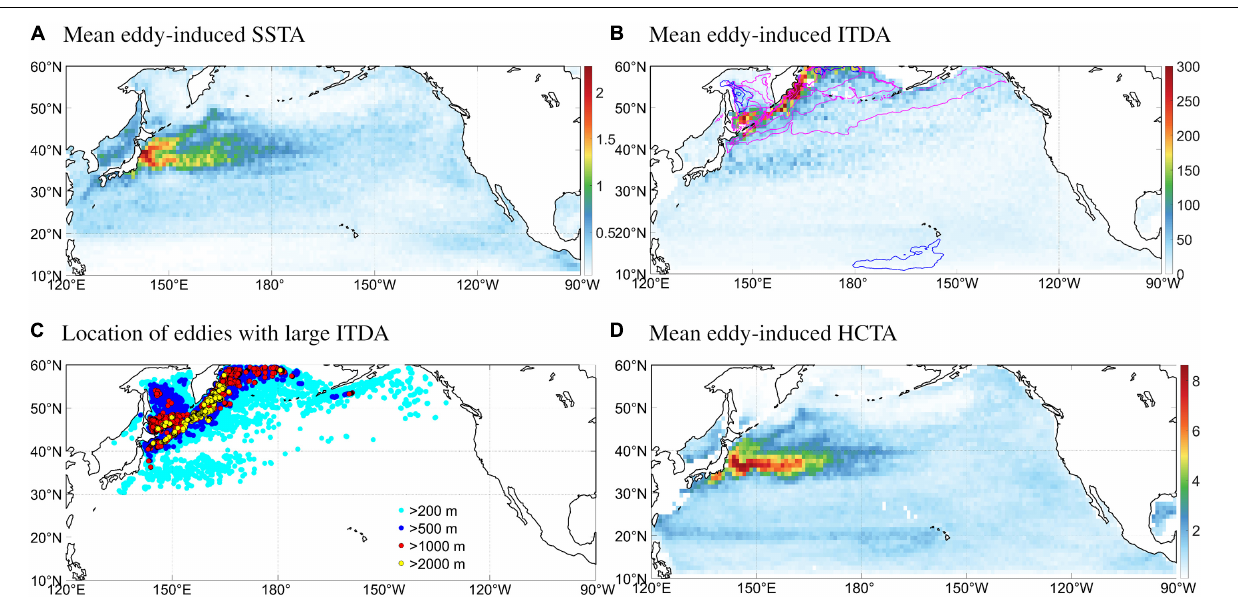
where T is temperature, c is specific heat capacity, and ρ is density. of mean eddy-induced thermodynamic anomalies is shown in Figure 4 . On average, eddies in the Kuroshio and Oyashio Extension region are most effective in changing the SST, with mean SSTA of more than 2 ◦ C ( Figure 4A ). The largest SSTA appears in the confluence region between the Kuroshio and the Oyashio, reflecting the vigorous poleward heat transport by mesoscale eddies (Sugimoto and Hanawa, 2011; Seo et al., 2014; Sugimoto et al., 2014; Masunaga et al., 2016), and along eddies are the strongest ( Figure 1D ). Eddy-induced ITDA is the largest in the northwest, especially along the Kuril-Kamchatka